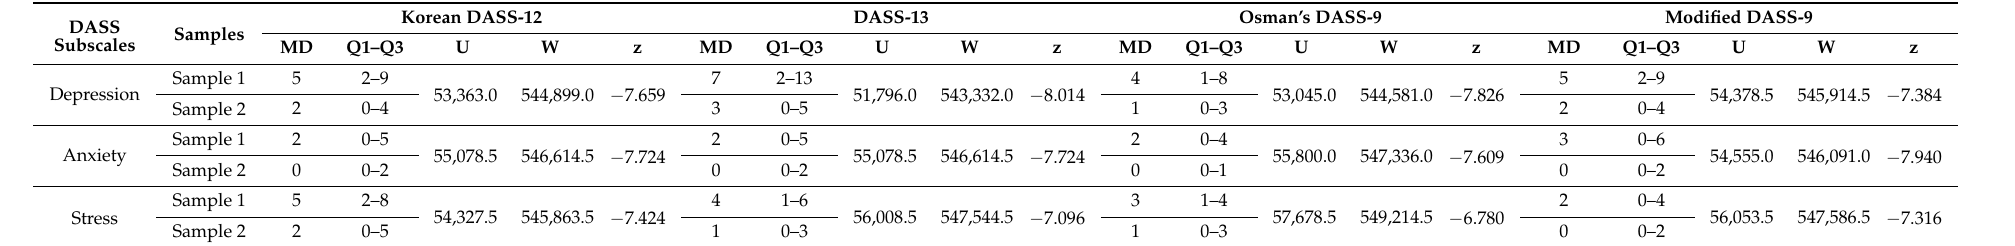
Table 6. Descriptive statistics and discriminant validity of subscales of shortened versions of the Depression Anxiety Stress Scale